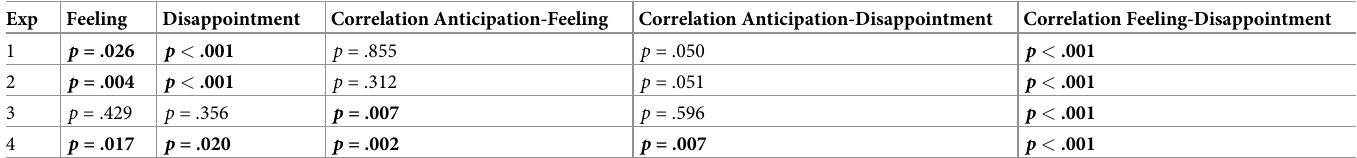
Table 1. Overview of results. The table provides an overview of the results from Experiments 1–4. Values in bold indicate a statistically significant results, assuming an alpha level of